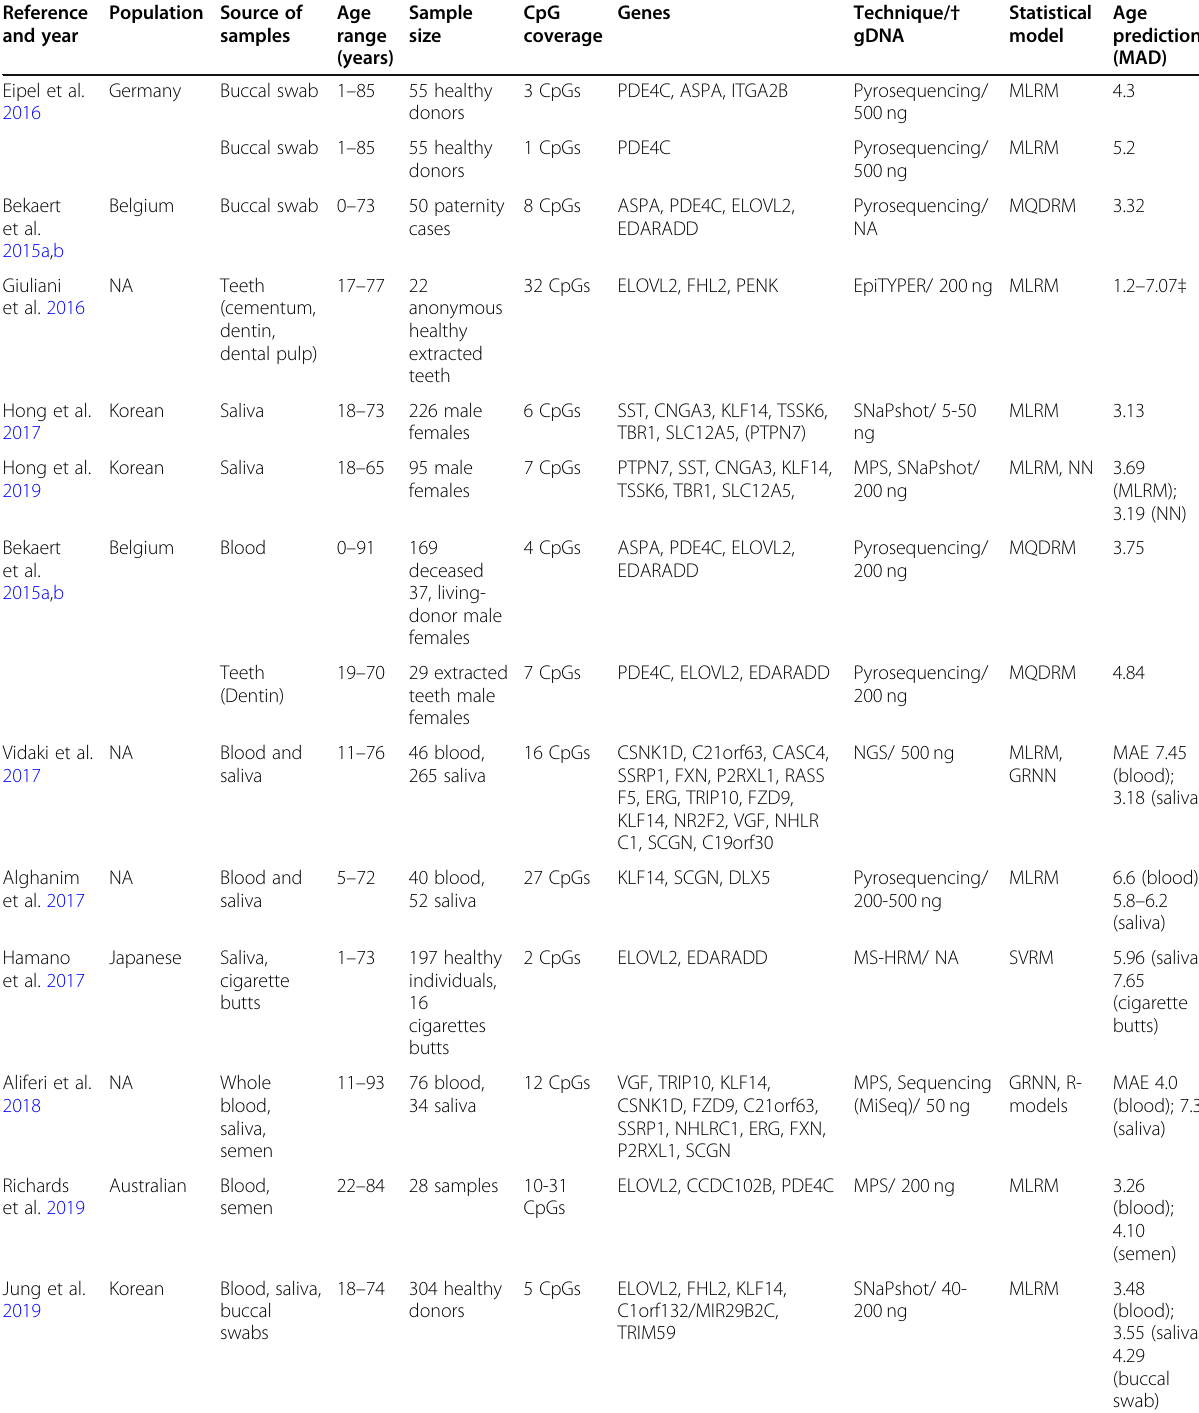
Table 2 DNA methylation methods for age estimation in forensic studies (Continued) Reference and